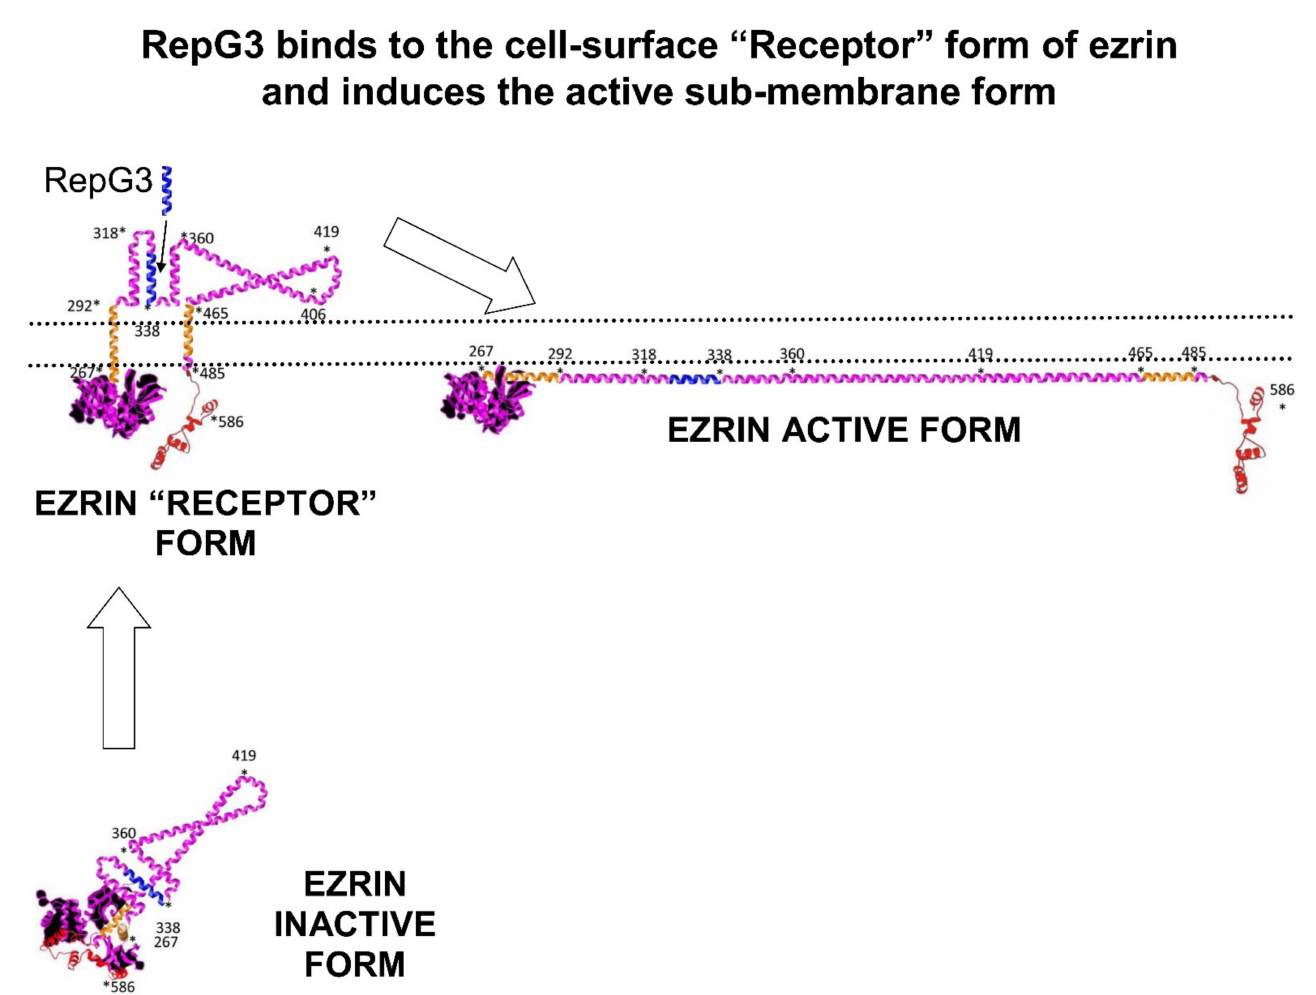
Figure 16. RepG3 may bind to a cell-surface “Receptor” form of ezrin, leading to allosteric conformation changes and the induction of the active sub-membrane form of ezrin followed by the assembly of protein signalling complexes. The white arrows represent the transitions from the inactive form of ezrin, to the “receptor” form of ezrin to the active form of